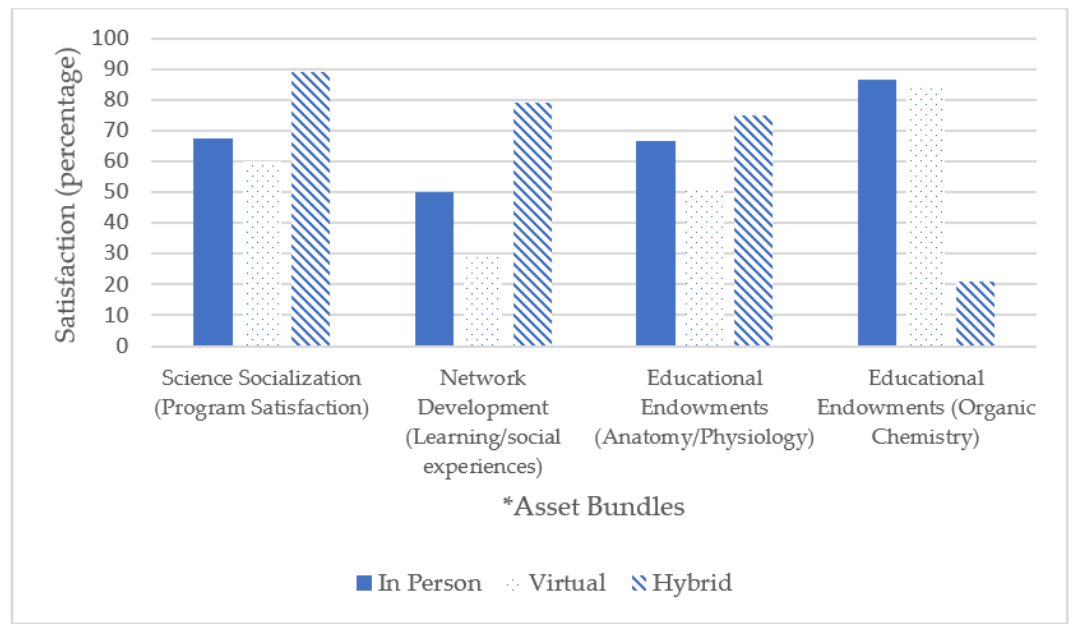
Figure 1. Satisfaction scores for asset bundles based on delivery format.* This study focuses on three asset bundle domains; (1) science socialization-the connection between scientific careers and the ability to serve community goals, (2) network development-building positive social capital through mentoring relationships and involvement in extracurricular activities, students, and (3) educational endowments-access to additional resources and educational support including additional study material and innovative lectures.